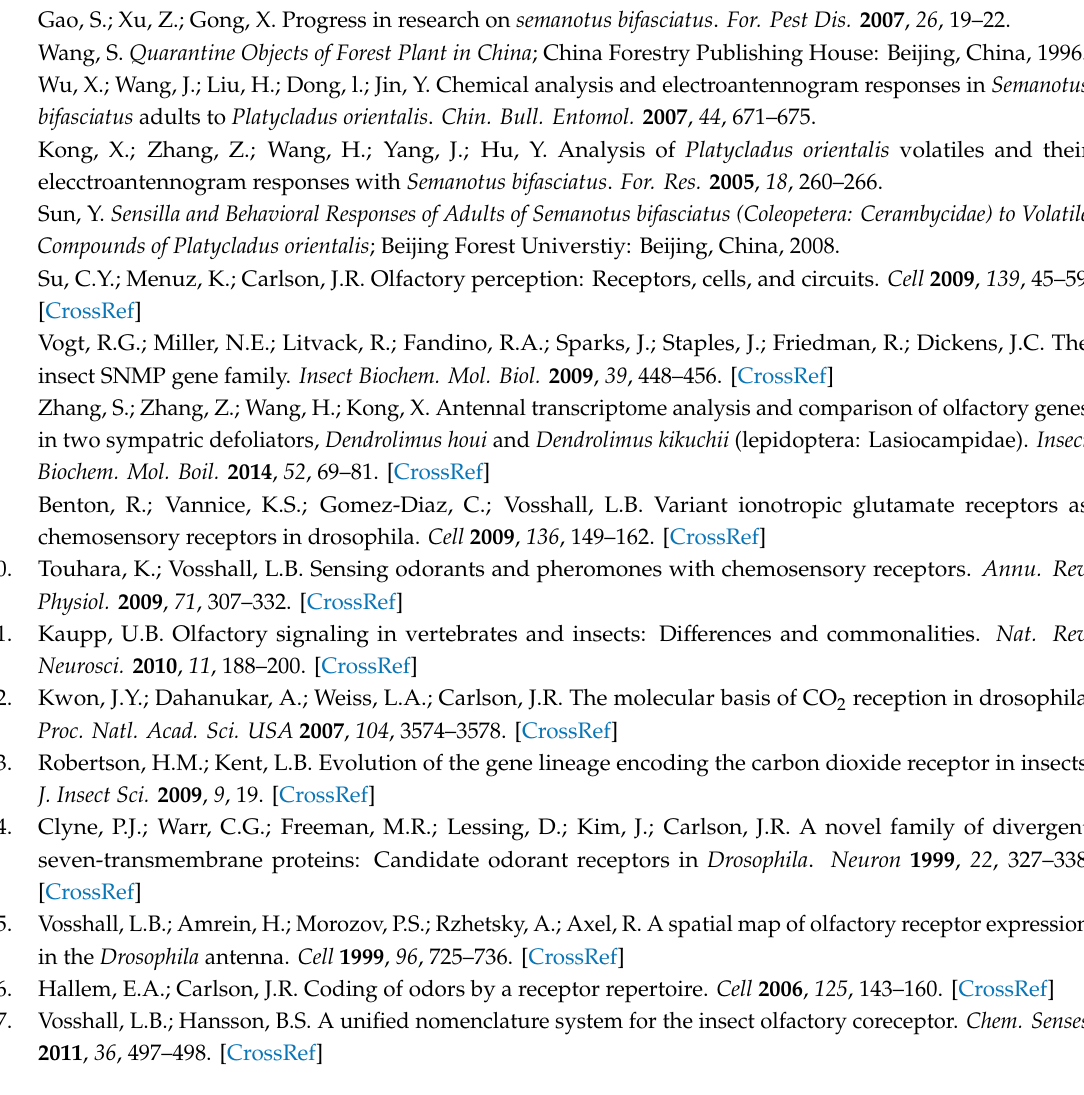
Table S1: Identified chemosensory genes in S. bifasciatus and their unigene ID, Table S2: Collected conserved SNPs in two S. bifasciatus populations, Figure S1: Comparison of chemosensory protein (CSP) genes expression levels in both sexes of the two S. bifasciatus populations. The horizontal axis refers to the expression level of the genes (FPKM values, mean ± SE, n = 3), Figure S2: Comparison of gustatory receptor (GR) genes expression levels in both sexes of the two S. bifasciatus populations. The horizontal axis refers to the expression level of the genes (FPKM values, mean ± SE, n = 3), Figure S3: Comparison of ionotropic receptor (IR) genes expression levels in both sexes of the two S. bifasciatus populations. The vertical axis refers to the expression level of the genes (FPKM values, mean ± SE, n =